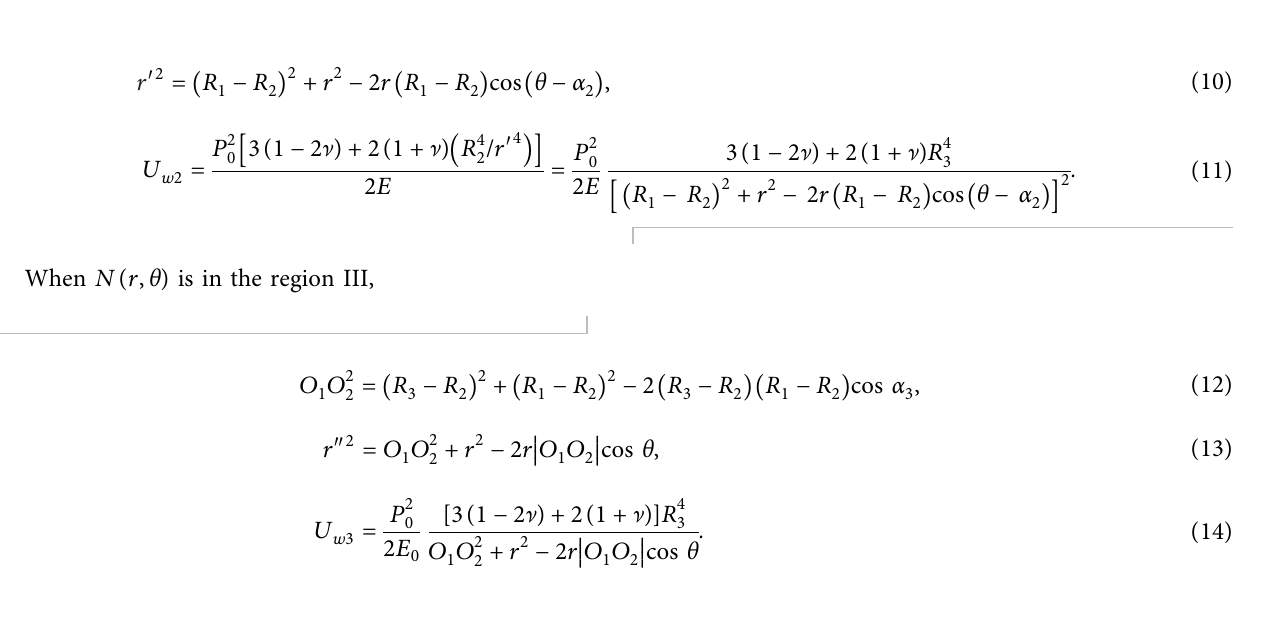
Figure 5: The relationship between geostress and